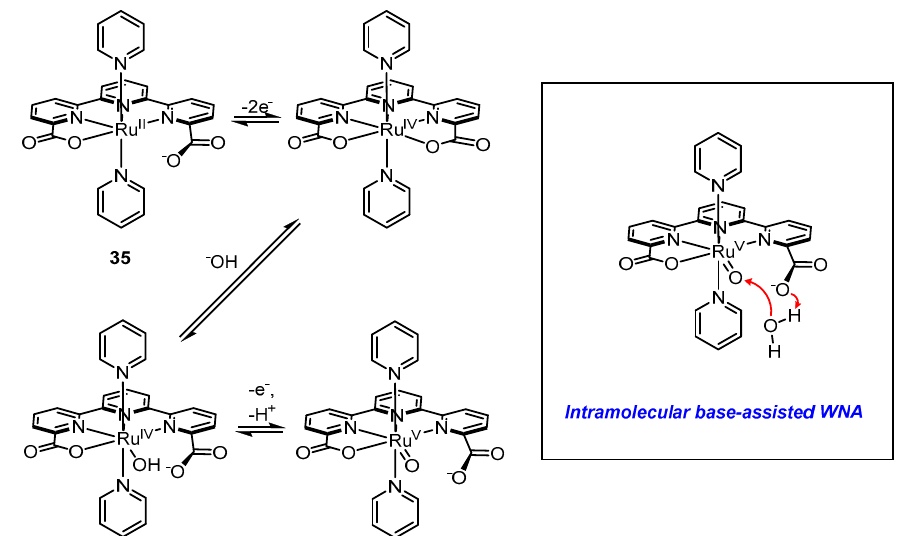
II (tda- κ 4 -N 3 O)(py)] ( 35 ).